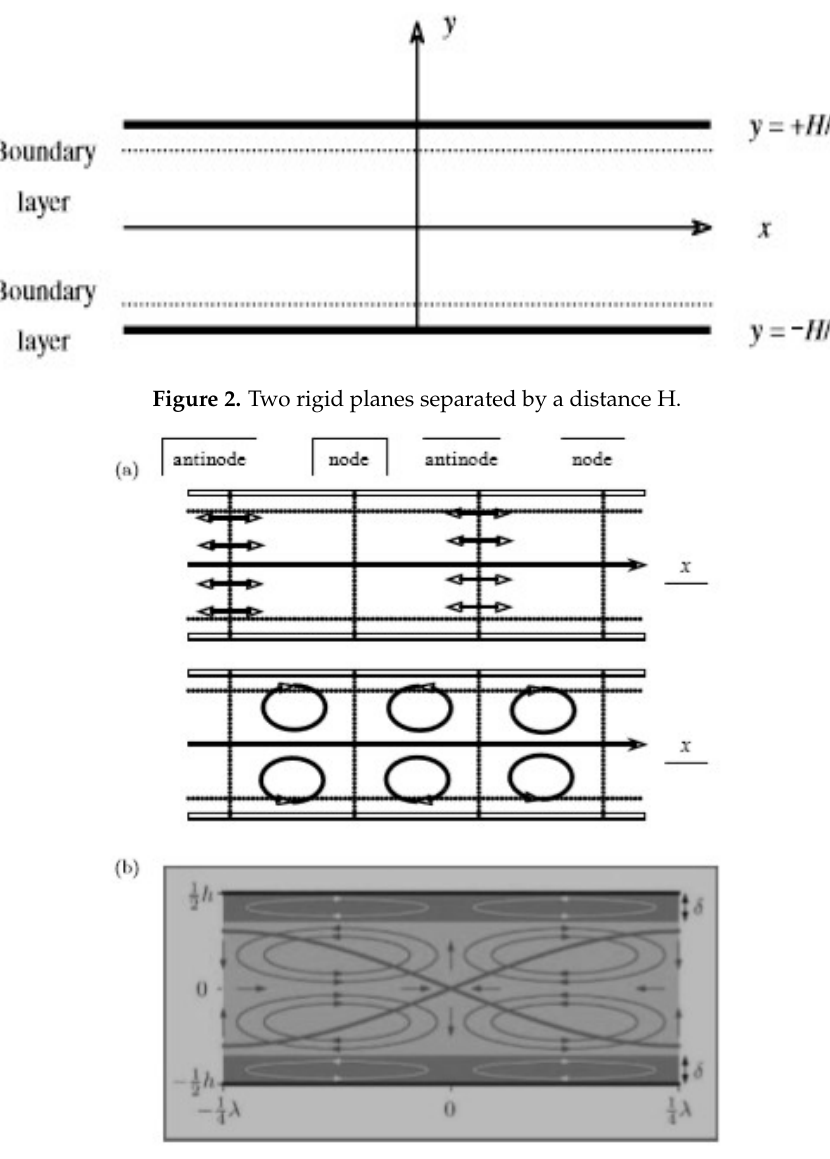
Figure 3. ( a ) Acoustic streaming in a standing wave: the standing wave’s spatial period is twice that of vortex-rings of acoustic streaming; ( b ) acoustic streaming pattern between ( − λ /4) on the left of an antinode to λ /4 on the right of the antinode. Note the streaming directions within viscous boundary layers, δ , are counterclockwise directions of those outside the boundary. Reproduced with permission from [34].